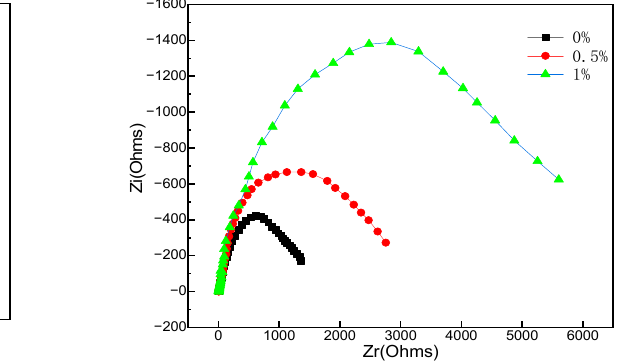
( a ) Overall impedance curve ( b ) Partial enlargement of impedance curve Figure 7. EIS in 3.5% NaCl solution: Nyquist. Figure 7. EIS in 3.5% NaCl solution: Nyquist. According to [13], the larger the radius of the capacitive arc in the Nyquist plots diagram, the better the corrosion resistance of the surfacing layer. It can be seen from Figure 7 that the corrosion resistance of the arc surfacing layer is the same. When boron is not added, the capacitive reactance radius of the surfacing layer is the smallest. When